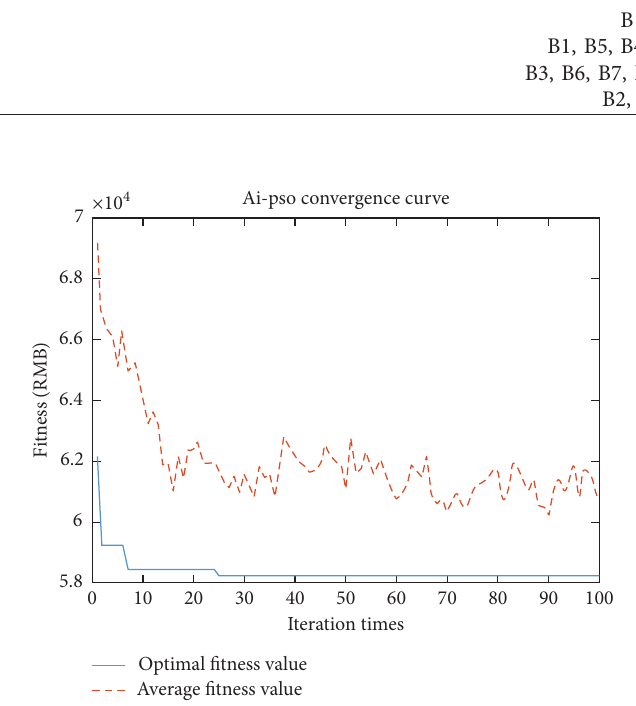
Figure 9: Convergence curve of AI-PSO in a dynamic environment.